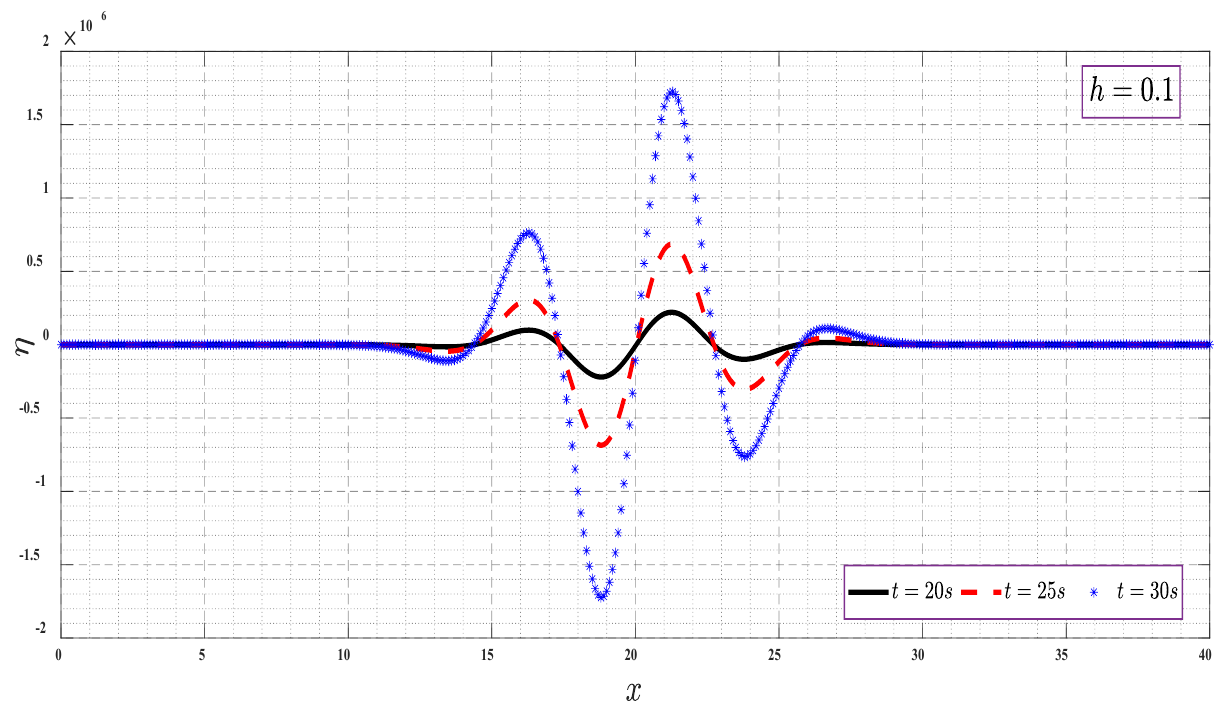
Figure 4. WSE ( η ) of SWWE at t = 20 s, 25 s, and 30 s ( h = 0.1).